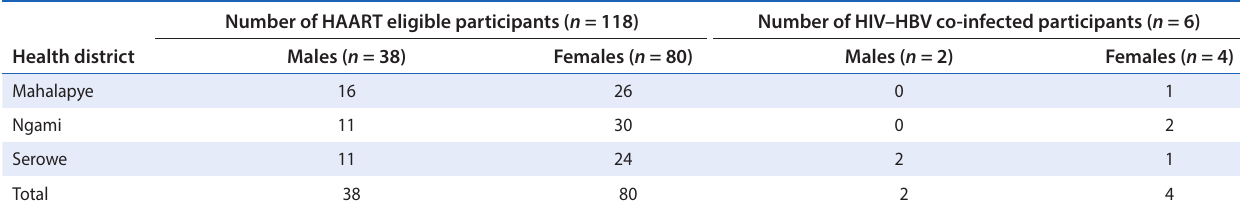
Table 2: Health district distribution of participants and HIV–HBV co-infected participants in the Mahalapye, Ngami and Serowe health districts; August to October